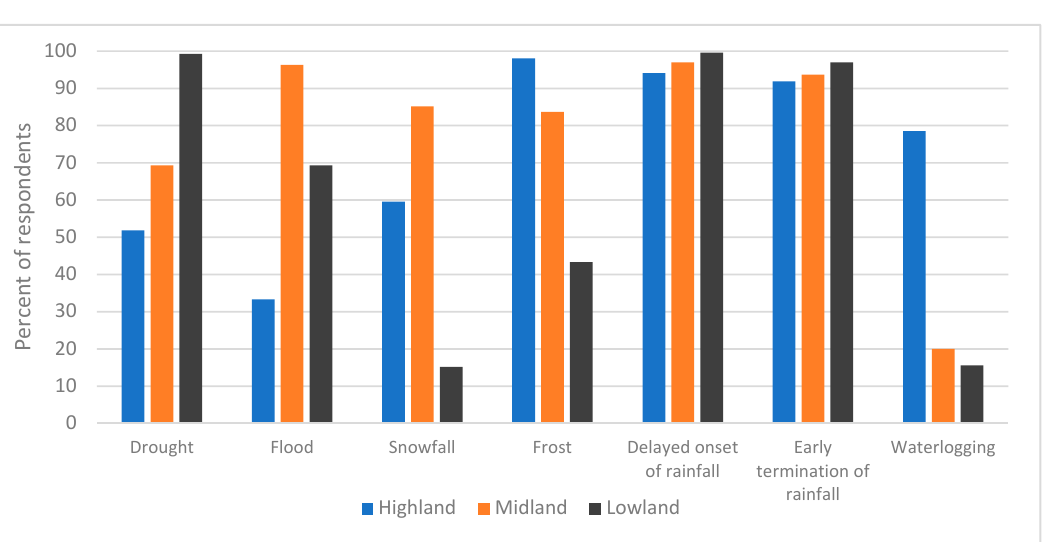
Figure 7. Distribution of households’ perceptions of climate variability and extreme events by agro-ecological settings.